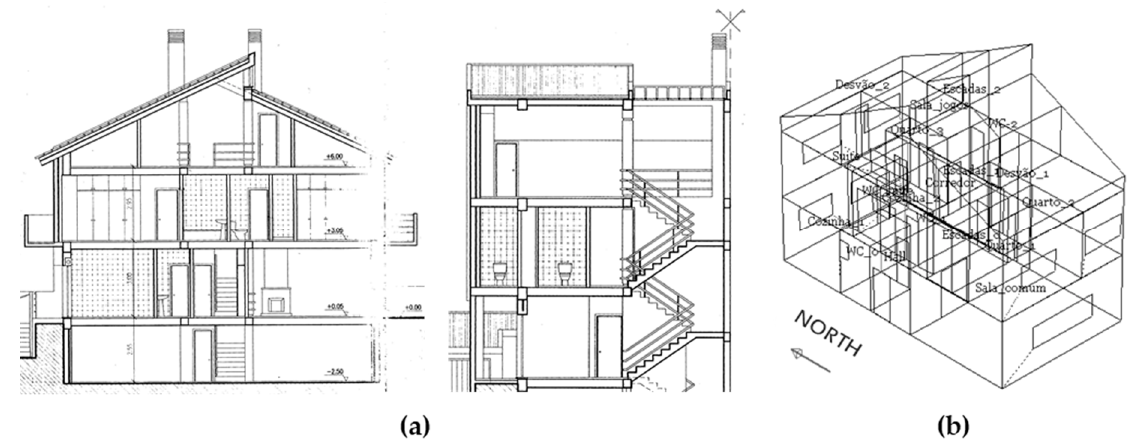
Figure 2. ( a ) Building sections, and ( b ) a 3D model of the simulated Figure 2. (a) Building sections, and (b) a 3D model of the simulated building. Figure 2. (a) Building sections, and (b) a 3D model of the simulated building.